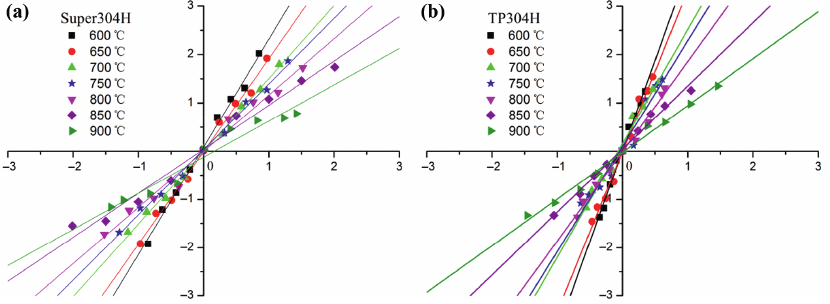
Figure 5: Linear fitting lines of Z versus x of the diffusion couples of Super304H (a) and TP304H (b)